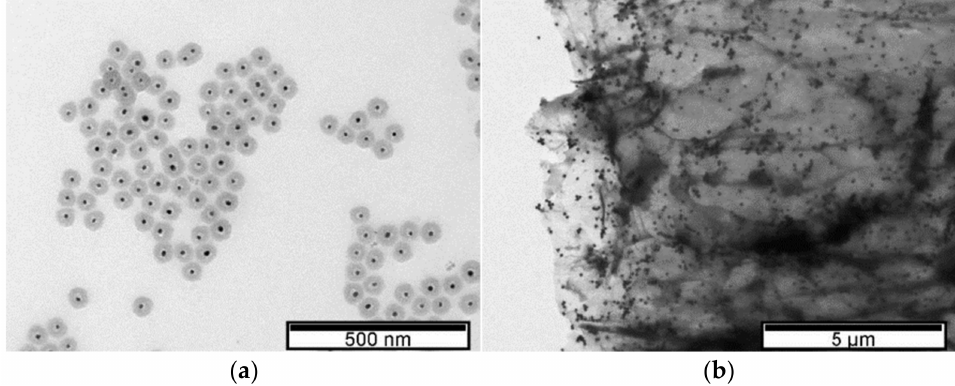
Figure 3. TEM images. ( a ) AuNPs in 5% tea extract. ( b ) rGO-supported AuNPs in 5% tea